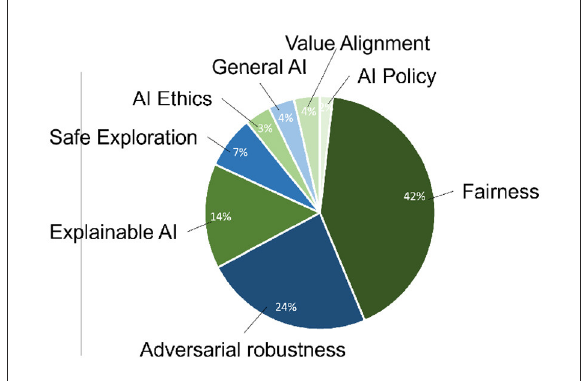
FIGURE4 Relative occurrences of categories in database.